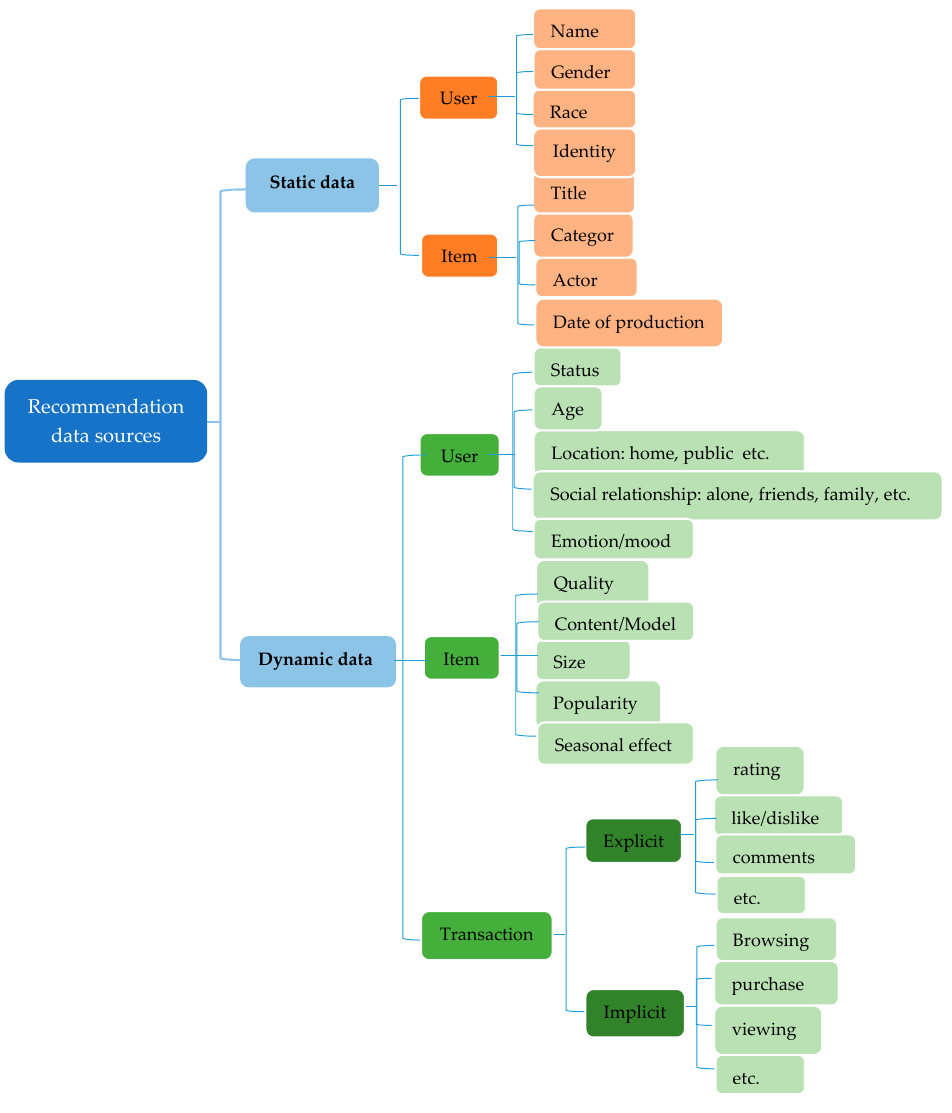
Figure 1. Taxonomy of data source for building recommendation.